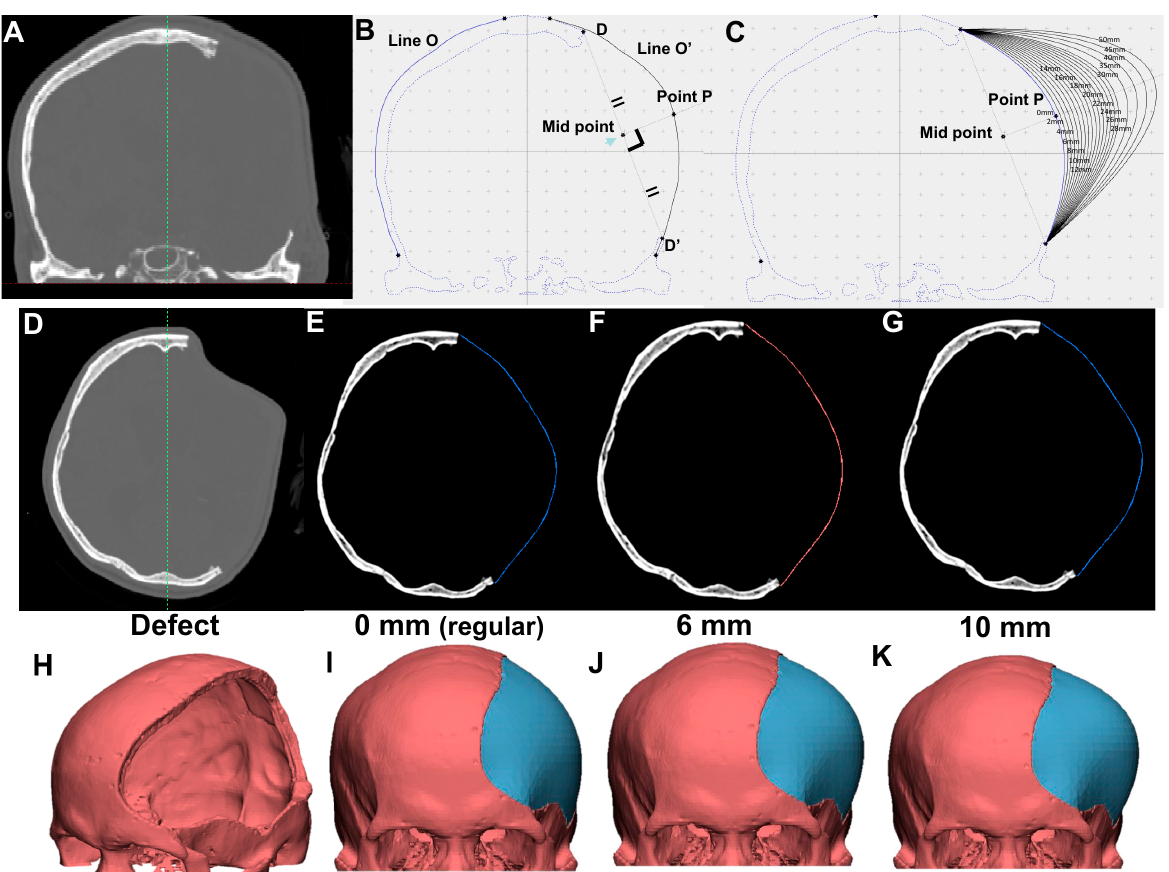
Figure 2. Three-dimensional (3D) computer-assisted design (CAD) model for skull defect reconstruction of case 3 using OpenCV and OpenGL OBJ Viewer. ( A ) CT bone window image with left skull defect. ( B ) Schematic illustration of symmetric (regular) contour planning. ( C ) Schematic illustration of elevated contour of skull defect. Contours elevated outward every 2 mm up to 30 mm, and every 5 mm up to 50 mm. Reconstructed contour from skull defect ( D ), with symmetrically filled ( E ), 6 mm ( F ), and 10 mm ( G ) contour elevation ( H – K ) with respective 3D model shown using OpenGL OBJ Viewer. Reconstructed artificial flap is labeled in